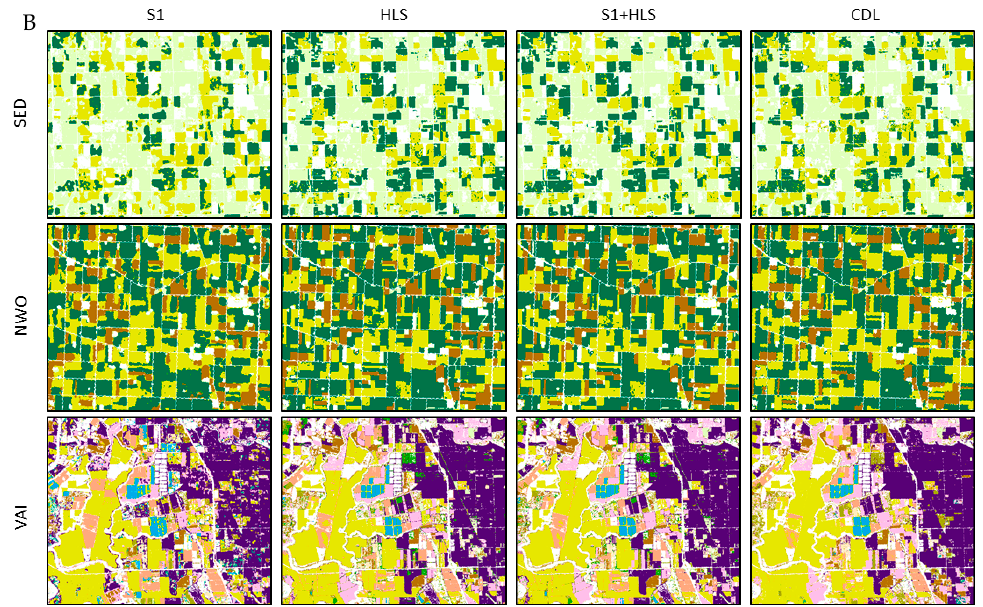
Figure 6. ( A ) The end of season crop type products for northwest Ohio, southeast South Dakota, and Sacramento Valley California by sensor type and combination; zoom-in continued on (B). ( B ) Representative zoomed in snapshots from (A), the end of season crop type products for southeast South Dakota, northwest Ohio, and Sacramento Valley California by sensor type and combination.